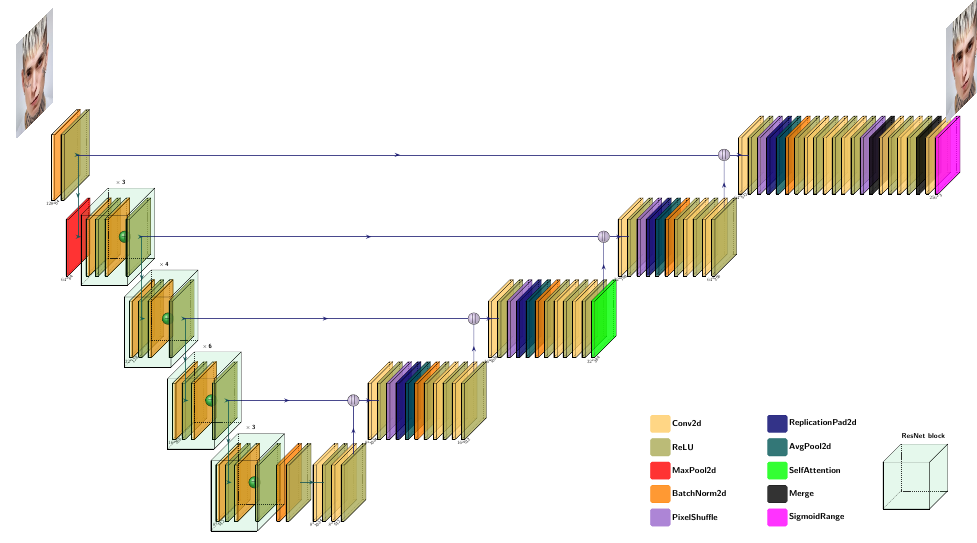
Figure 12. The encoder of the network is based on ResNet34, and the decoder consists of four main blocks and utilizes PixelShuffling [52]. The loss function is a combination of feature loss (perceptual loss) from [53], gram matrix style loss [54], and pixel (L1) loss. For the gram matrix loss and the feature loss, blocks from a pre-trained VGG-16 model are used [51,55].